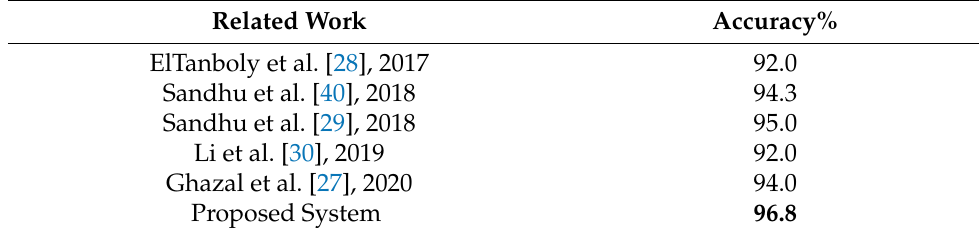
Table 4. Reported related work accuracies using OCT data.